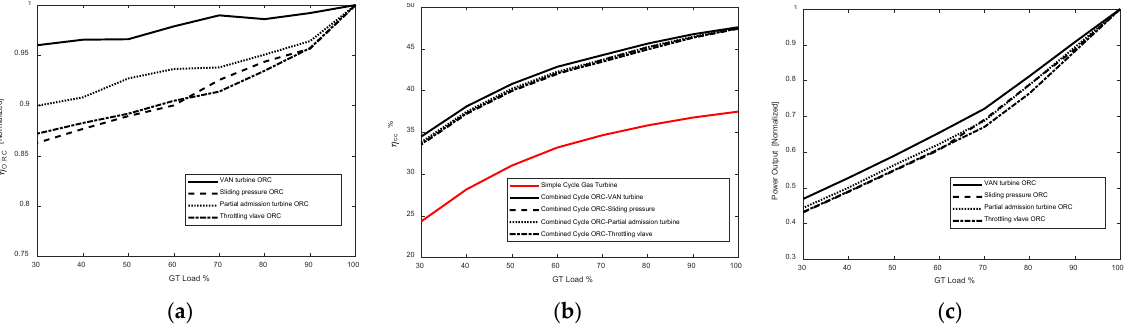
Figure 10. Part-load performance case A: ( a ) ORC efficiency; ( b ) Combined cycle efficiency; ( c ) ORC power output.